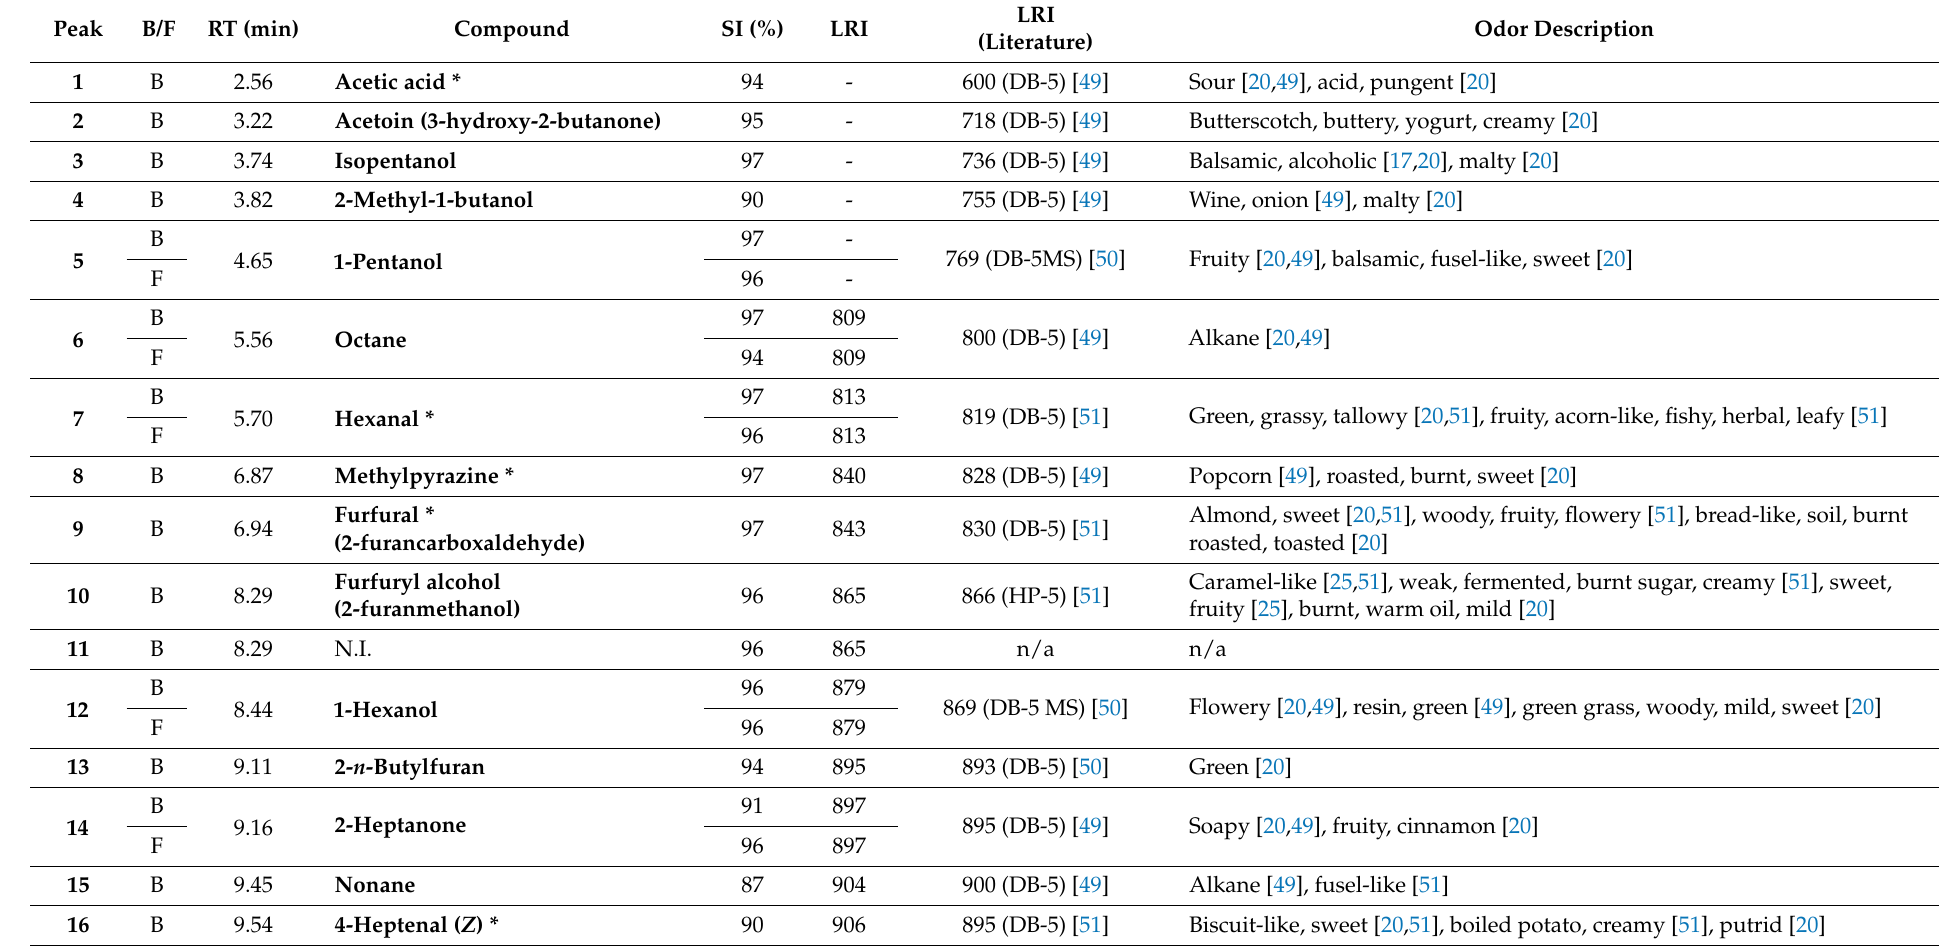
Table 2. Identification of detected compounds in maize flours (F) and broas